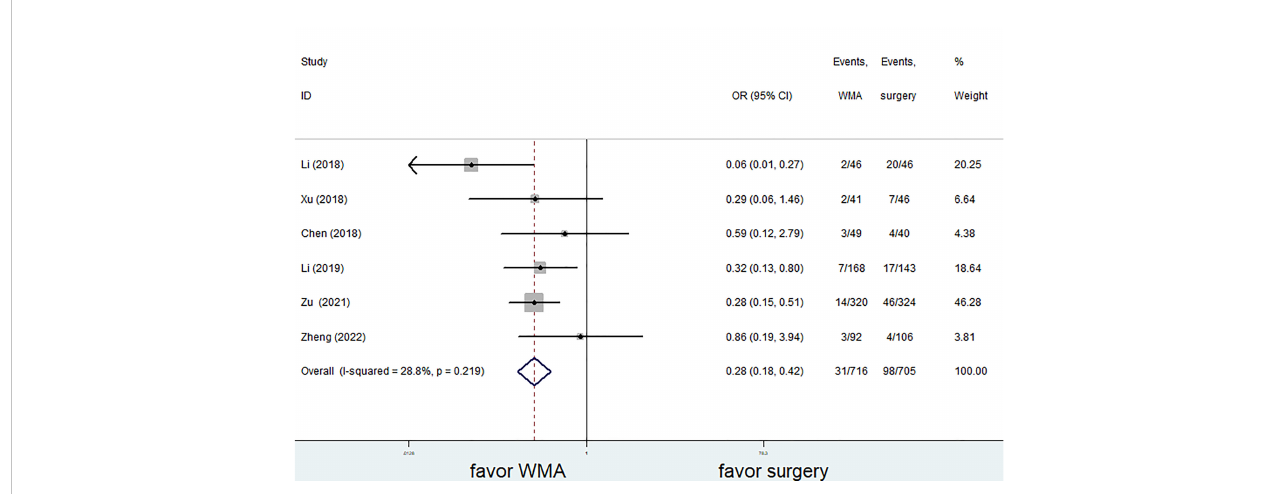
FIGURE 7 Forest plot of complications for comparing MWA with surgery in patient with PTMC. MWA, microwave ablation, PTMC, papillary thyroid microcarcinoma.